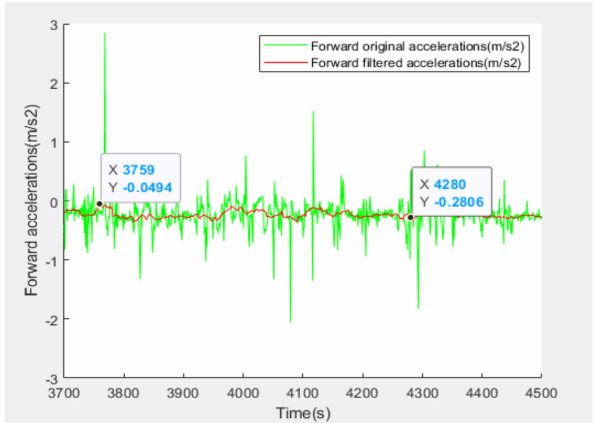
Figure 4. Forward accelerations at